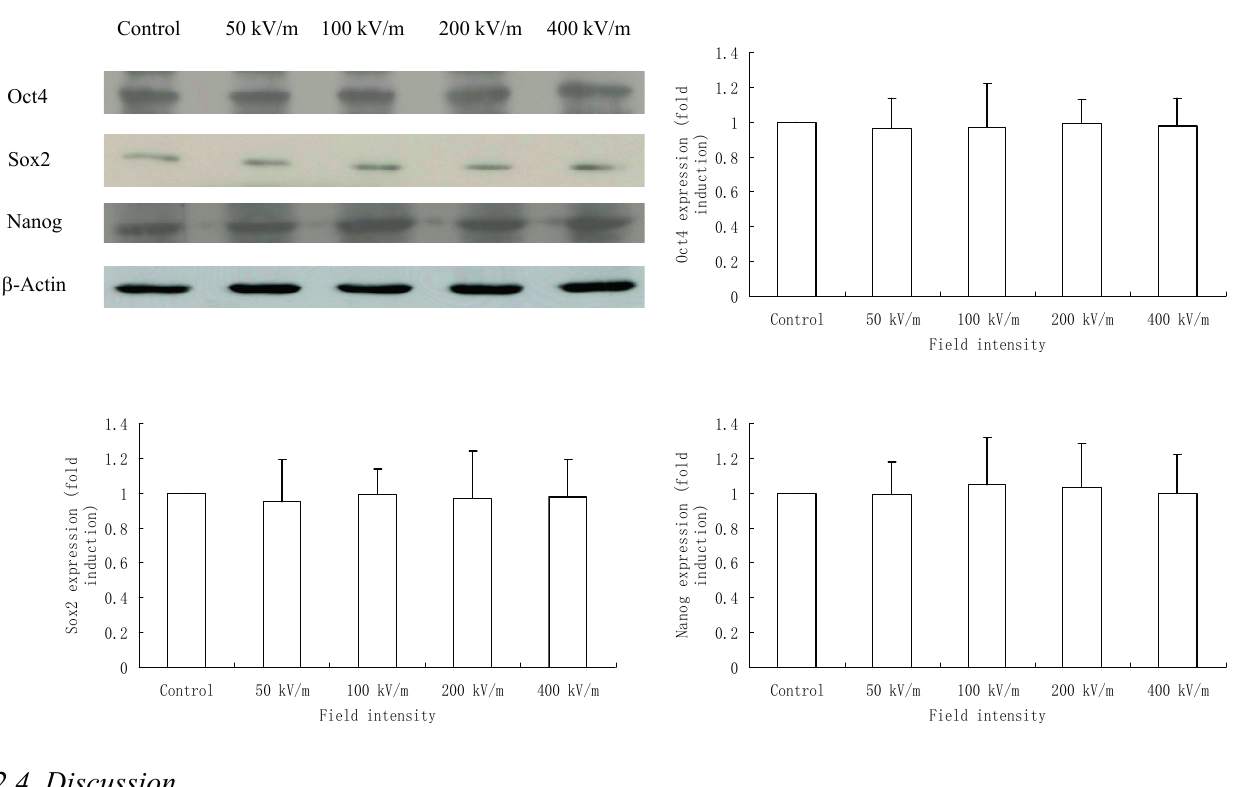
Figure 3. Western blotting analysis of Oct4, Sox2 and Nanog expression in HUES-17 human embryonic stem cells (hESCs) after exposed to PEMF at different electric field intensities (control group, 50, 100, 200, 400 kV/m). β -Actin was used as an internal control. Protein level of each gene was quantitated by densitometry and plotted as fold induction. Results were obtained from three independent experiments and expressed as mean ± SD ( n = 3 in each